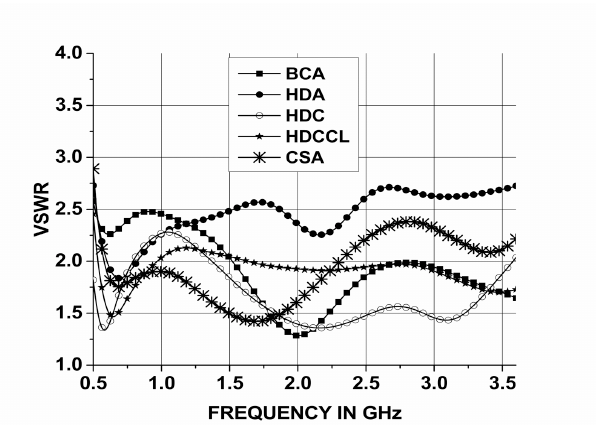
Figure 2: Comparison of Simulated VSWR of antennas The comparison of Gain at Horizon for all the antenna configurations is shown in figure 3.